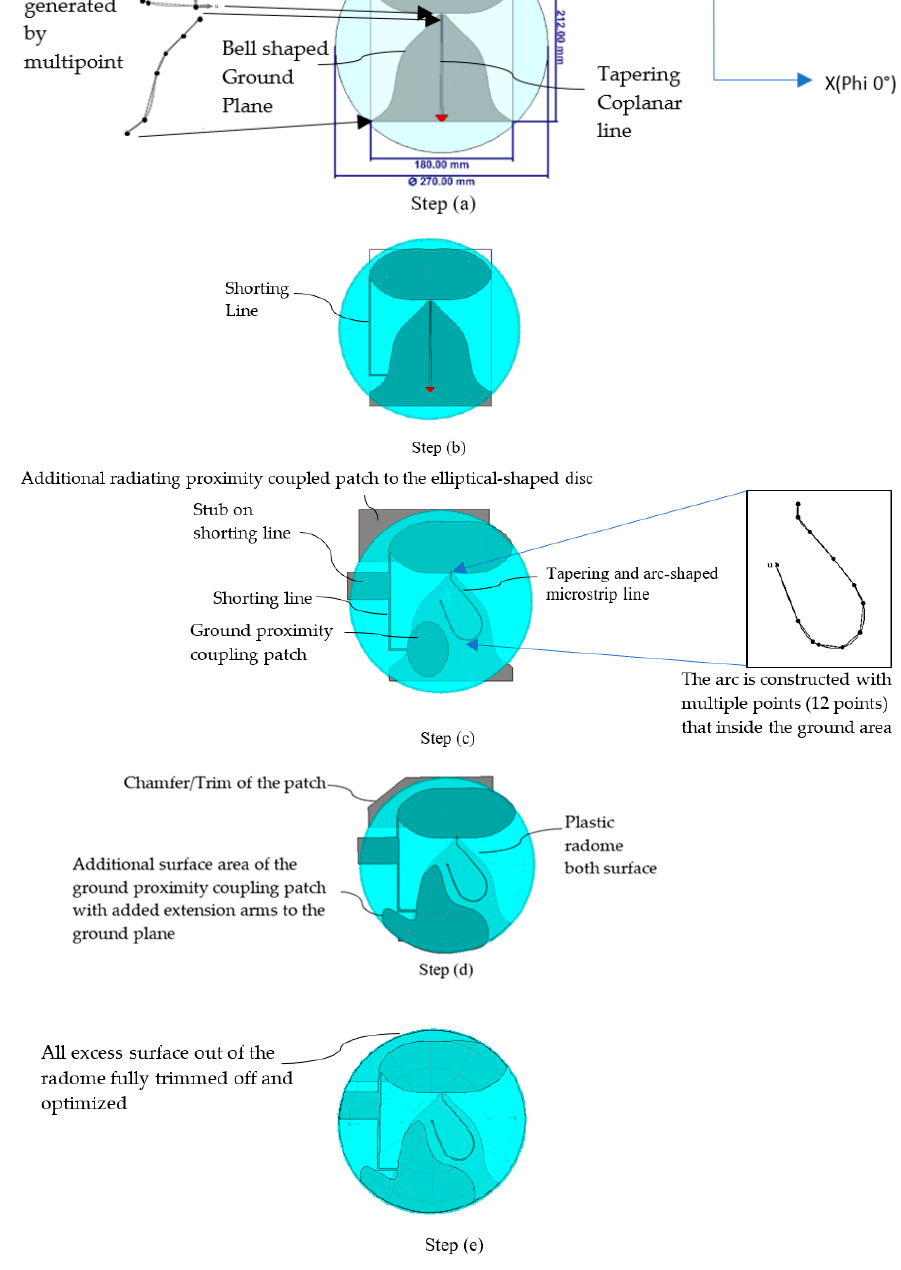
Figure 5. Evolution steps to make the antenna fit into the disc-shaped radome for ceiling mount antenna configuration. Step ( a ) Elliptical-shaped liked monopole with bell-shaped ground plane and tapering coplanar line; Step ( b ) Shorting line added in between the top radiator and the ground plane; Step ( c ) Conversion of the coplanar line to microstrip line, added stub on shorting line and proximity coupling patch (for radiating and ground portion); Step ( d ) Increase proximity ground patch size near the ground shorting line; Step ( e ) trim portion of the patch to fit into the radome and further optimized to have good impedance match at the lowest frequency range.